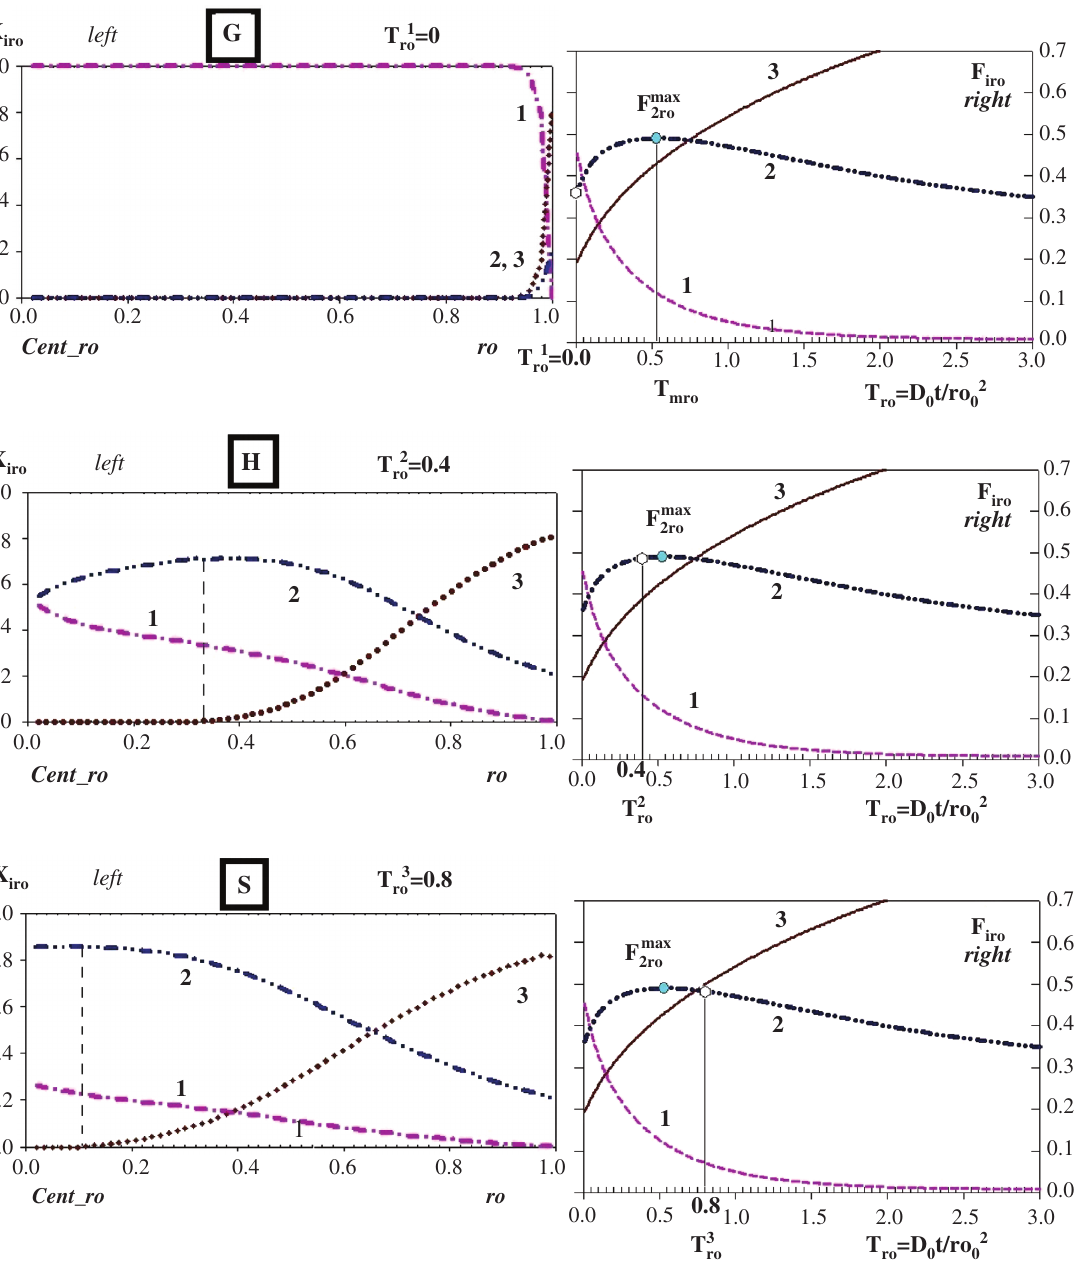
C, B waves): propagation of A , B , C waves ( left , 1-pink, 2-blue, 3-dotted) in 3 2 1 2 3 (T),( a , right ) ; F (T), ( b , right ). Maximum accumu- 2 r 2 ro = 0.51 ( b , right ). “White” k-points ( … ) in curves F (T), ( right ): T k = T m ro 2 r,ro = 0.20, D = 0.25 > > D = 0.01. Location of displacement effect 1 2 3